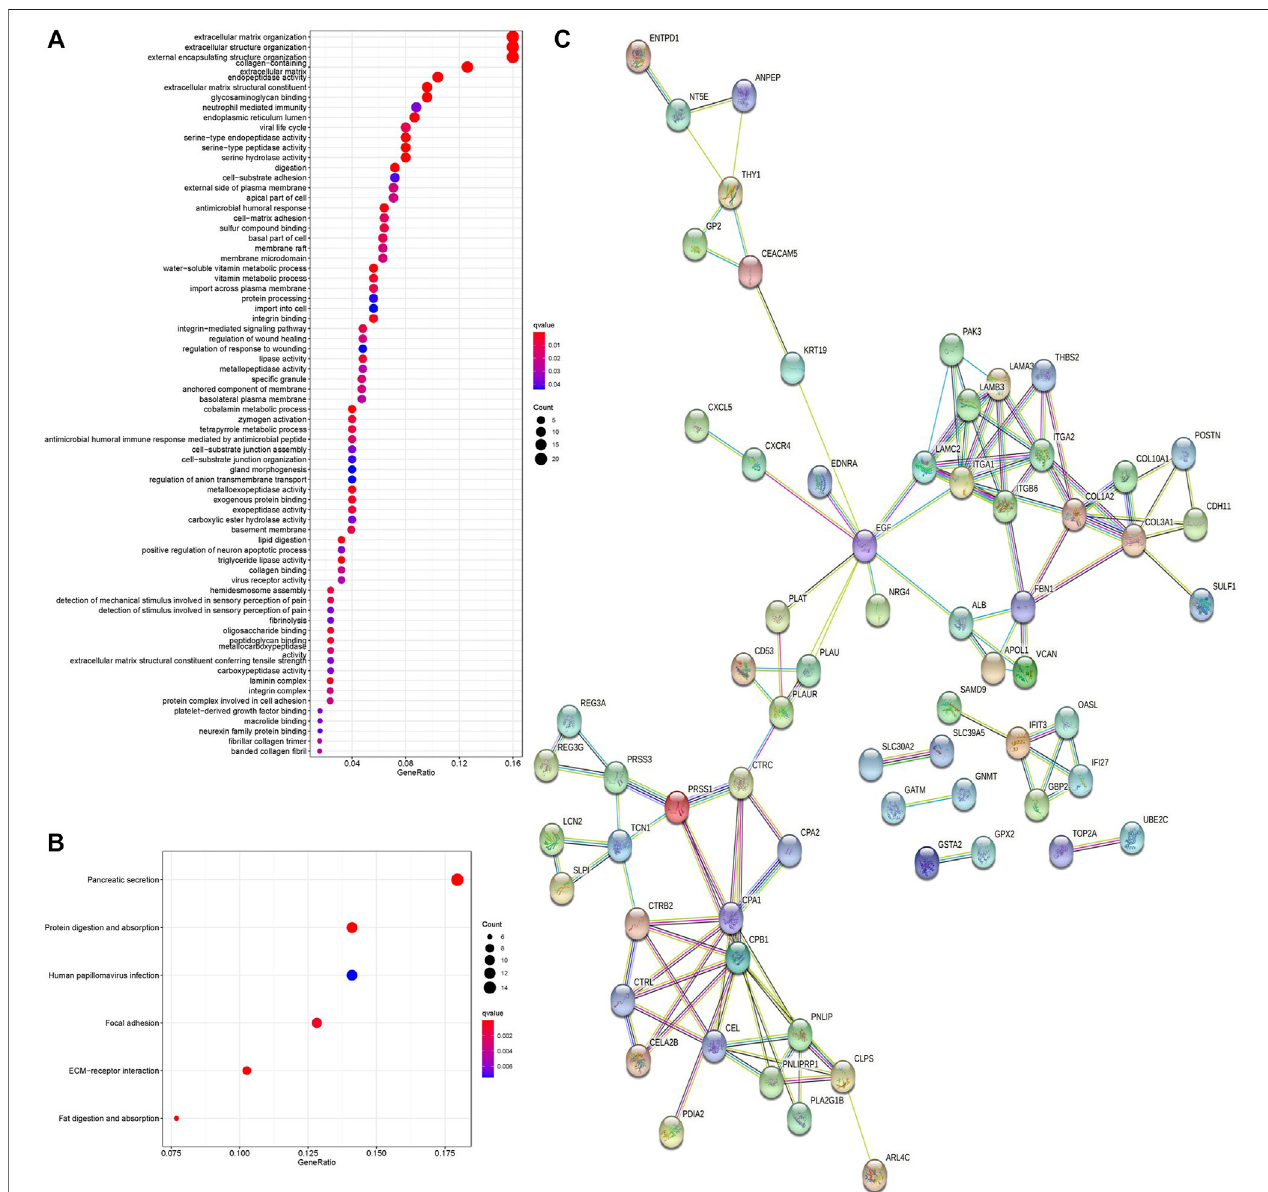
FIGURE 2 | GO enrichment analysis, KEGG pathway analysis, and PPI network of DEGs. (A) Bubble chart shows GO enrichment signi fi cance items of DEGs. (B) Bubble chart shows enrichment of DEGs in signaling pathways. (C) PPI network of DEGs. PPI, protein – protein interaction. GO, Gene Ontology. KEGG, Kyoto Encyclopedia of Genes and